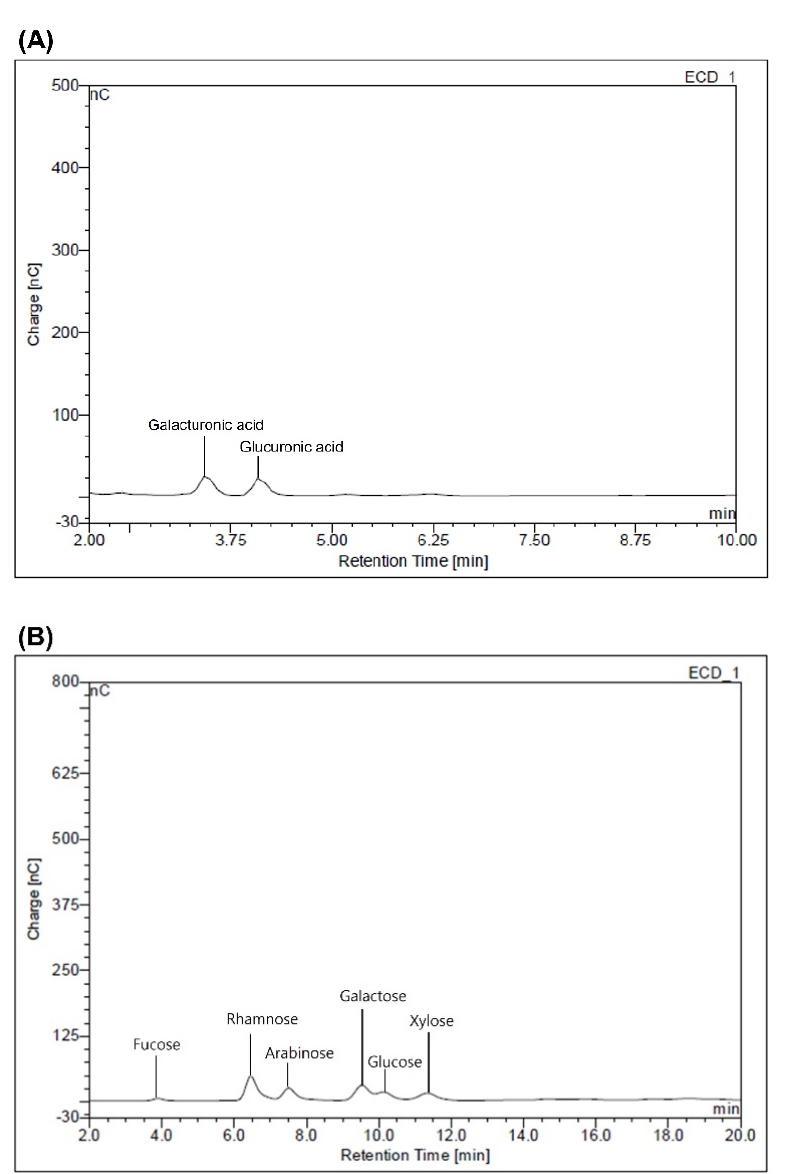
Results are shown as mean with standard deviation from triplicate.